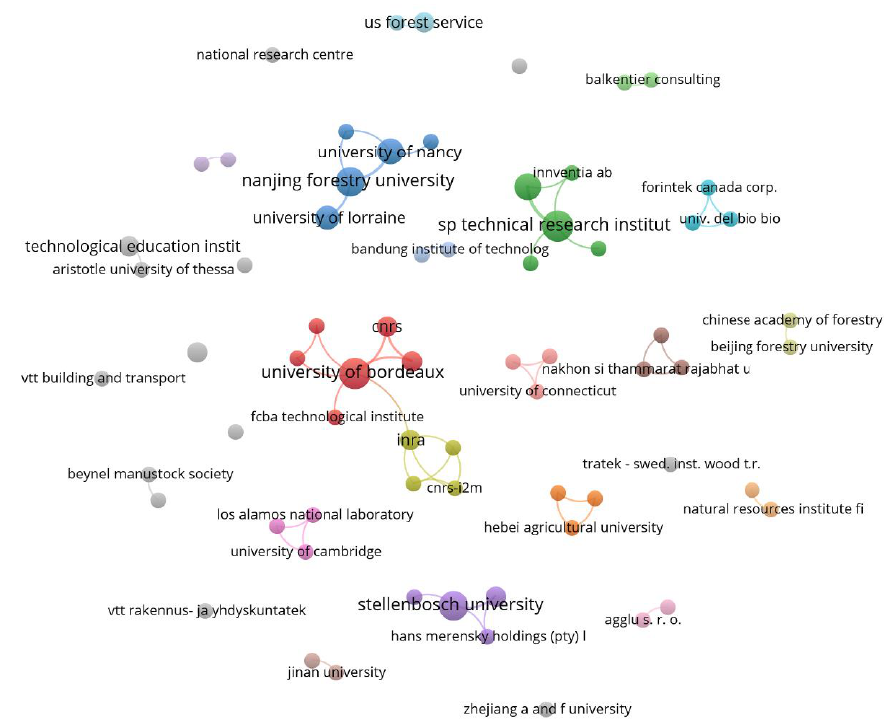
Figure 7. Analysis of co-authorship of institutions in network visualization (VOSviewer).